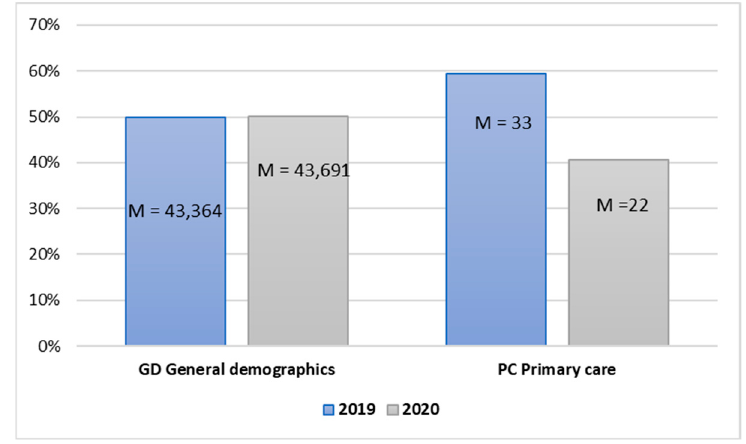
Figure 1. Independent sample mean values in the area of demographic data. Table 3. Test for dependent samples. Differences in Dependent Samples